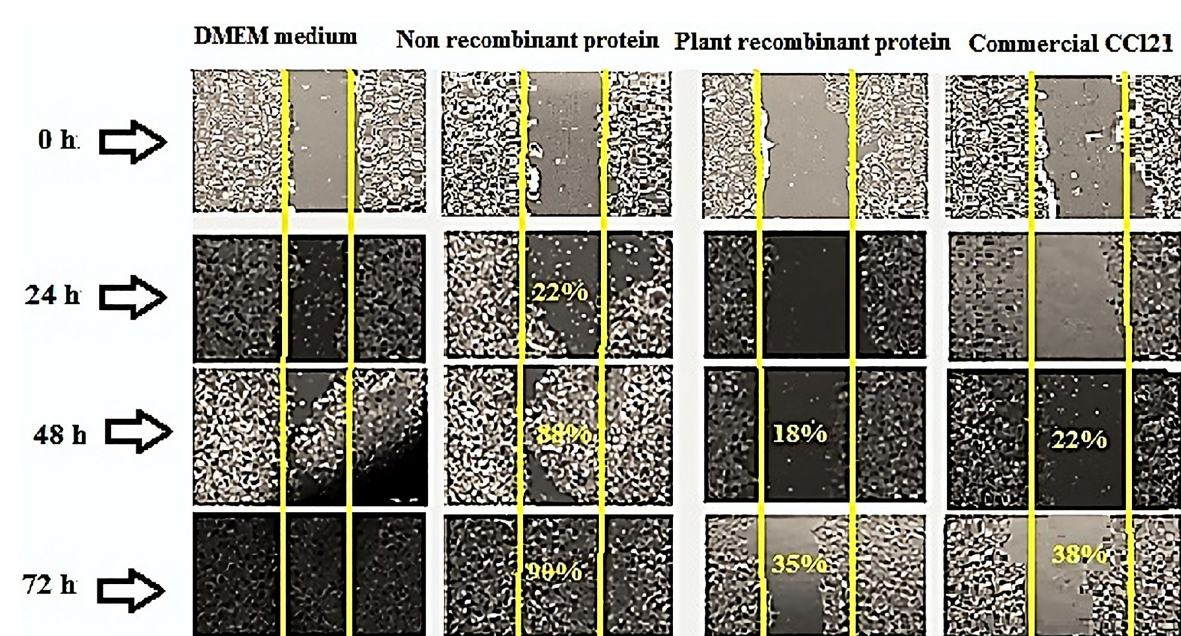
Fig 6. Photomicrographs of in vitro wound assay. The initial width of scratches in cancer cell cultures was estimated between 700 to 800 μ m. MCF7 migration rates were assessed at 0, 24, 48, and 72 hours after wound induction in each group. Treatments were non-recombinant protein extract and DMEM culture medium as negative controls, plant recombinant protein, and commercial CCl21 as the positive control. Medium concentrations of the extract (7.5 μ g/ml) induced migration of cancer cells and closure of the scratch, and closure percentage was calculated using Image J. software. When assessed 24 hours post-treatment, the two control groups had 22% migration to the scratch area. After 48 hours, 88% scratch closure was observed. Surprisingly, 72 hours following the same treatment, the scratch was almost completely closed. With the same concentration of the purified protein extract of transgenic leaves, however, no noticeable migration of the cells was detected 24 hours after treatment, and 15% and 28% scratch closure rates occurred after 48 and 72 hours, respectively.